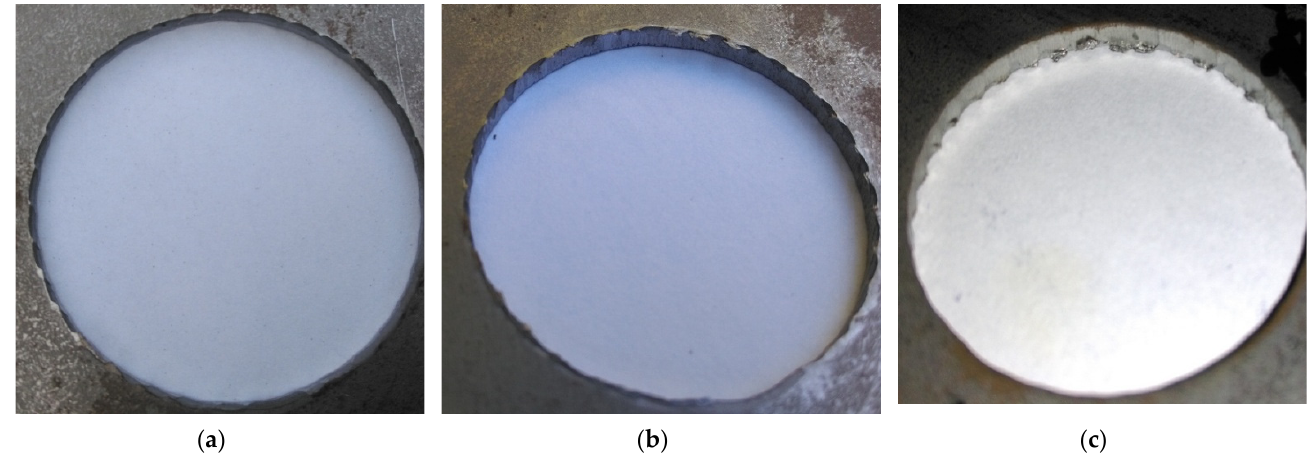
Figure 18. View of sample holes after the process: ( a ) 40,000 cycles; ( b ) 80,000 cycles; ( c ) 120,000 cycles.